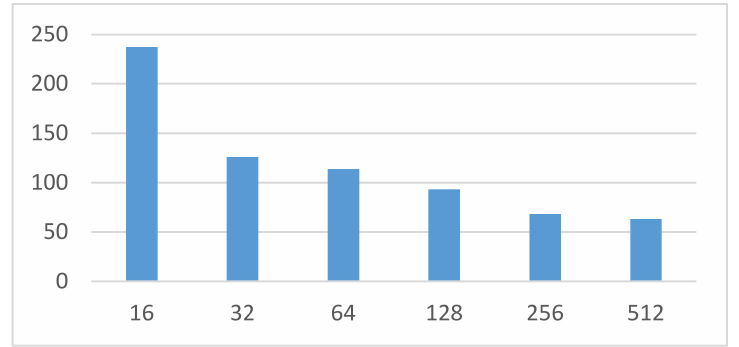
Figure 13. Training times of different batch